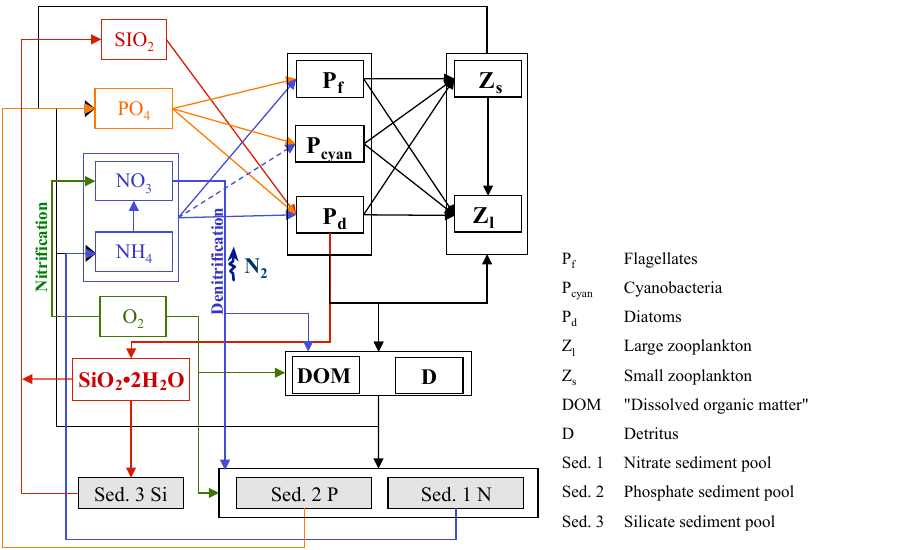
Figure 2. Schematic diagram of biological–chemical interactions in ECOSMO II (Daewel and Schrum, 2013).